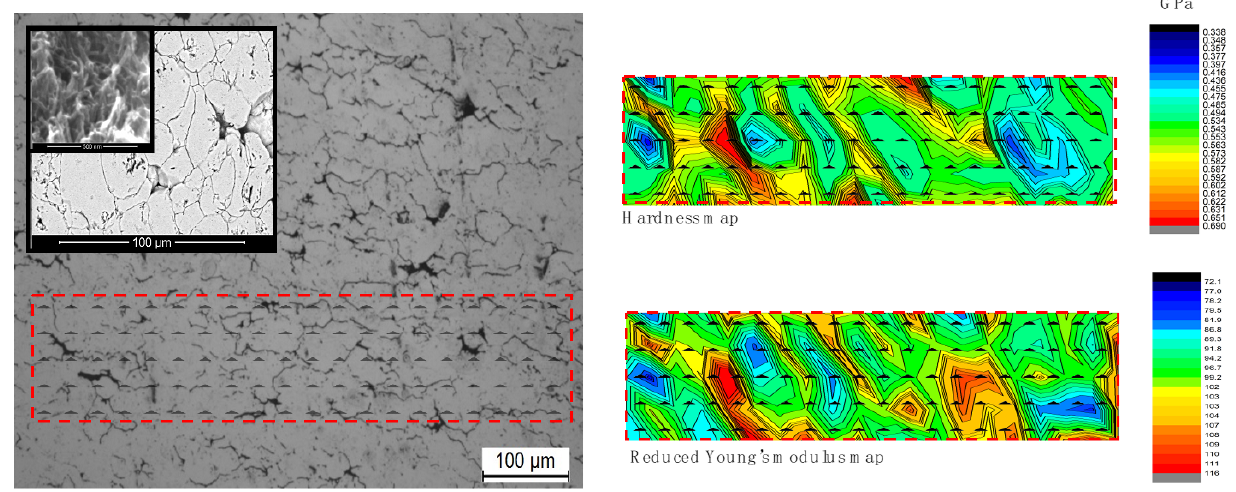
Figure 7. OM image with an SEM detail and with the nanoindentation matrix marked and hardness and reduced Young’s modulus (Er) maps in the